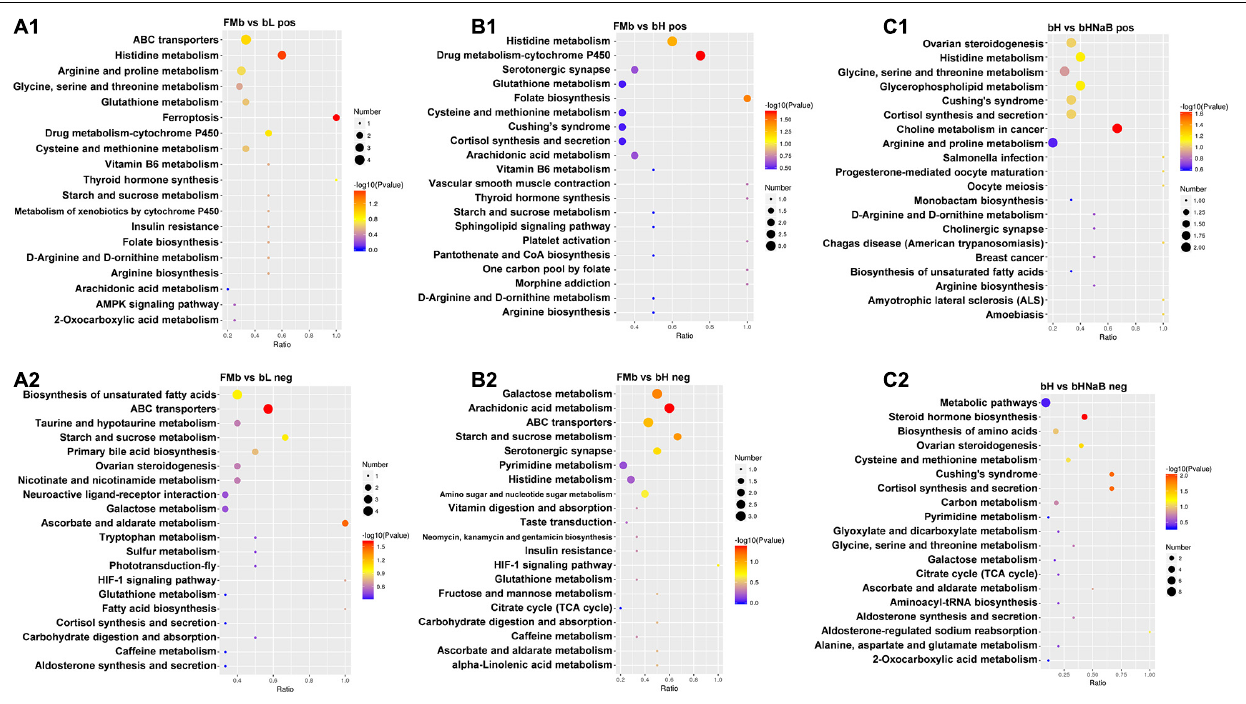
FIGURE 9 | Metabolic pathway enrichment analysis following positive and negative mode ion. DMs were enriched in the different comparison objects. FMb vs. bL: positive (A1) and negative (A2) ions; FMb vs. bH: positive (B1) and negative (B2) ions; bH vs. bHNaB: positive (C1) and negative (C2) ions.